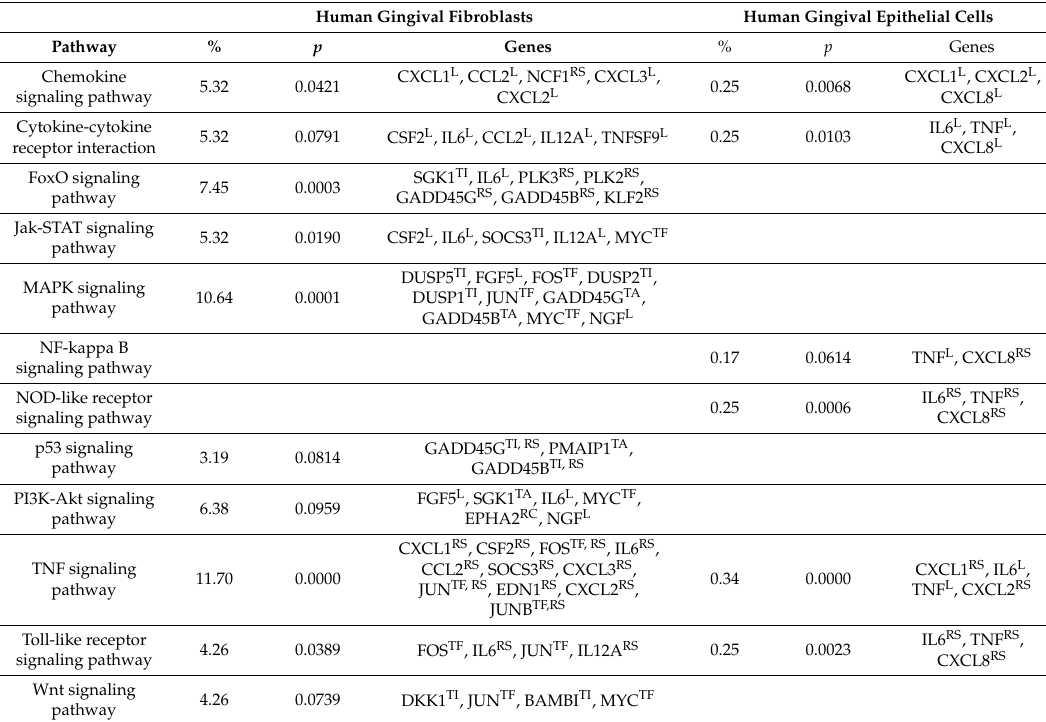
Table 1. Enriched pathways of upregulated genes from HGFs and HGEps after challenge with the S. oralis biofilm for 2 h. The potential role of each gene in the signal transduction of respective pathways is